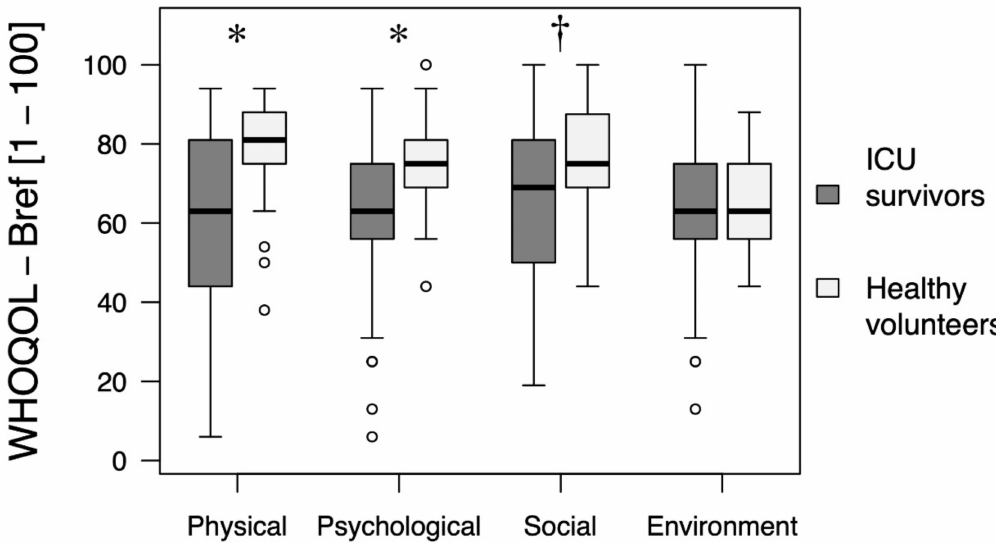
Figure 2. A comparison of the quality of life between patients discharged from the Intensive Care Unit and the group of healthy volunteers, as assessed by the WHOQOL-Bref questionnaire. * p -value < 0.001; † p -value = 0.006.